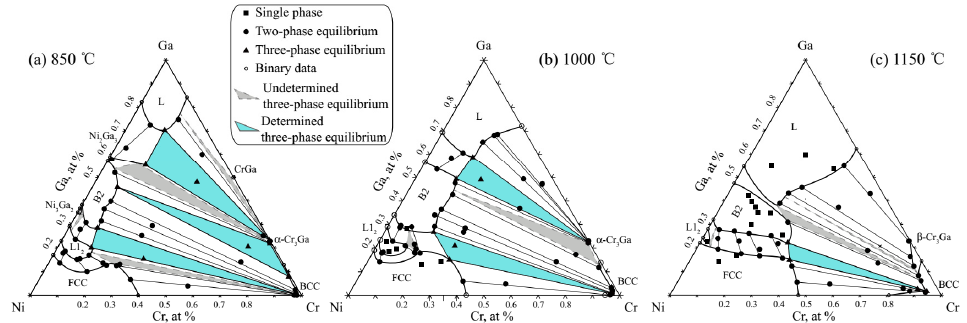
Figure 5. ( a – c ). Constructed isothermal sections of the Ni-Ga-Cr ternary system at 850 ( a ), 1000 ( b ) and 1150 ◦ C ( c